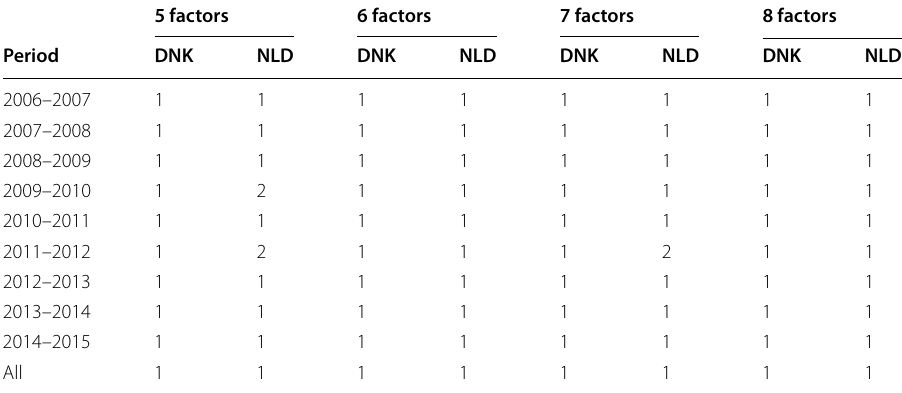
Table 7 Best-performing shortcuts to the complete multiplicative SDA, by share of the best